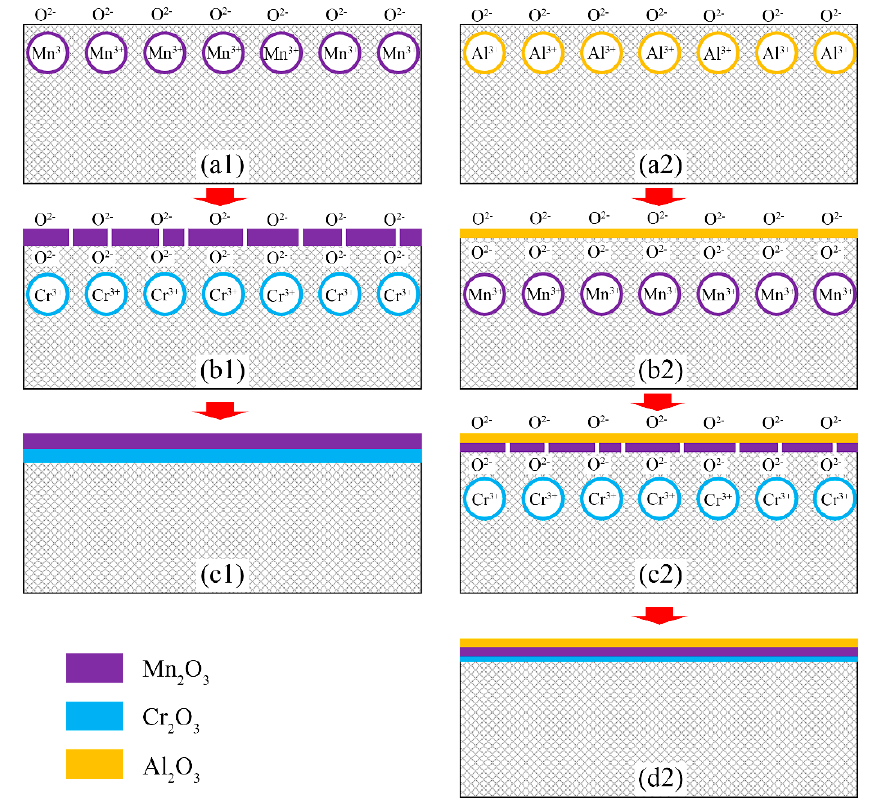
Figure 9. Schematic diagrams of oxidation mechanisms of the FeCoCrNiMnAl x cladding layers: ( a1 – c1 ) x = 0; and ( a2 – d2 ) x = 0.75.